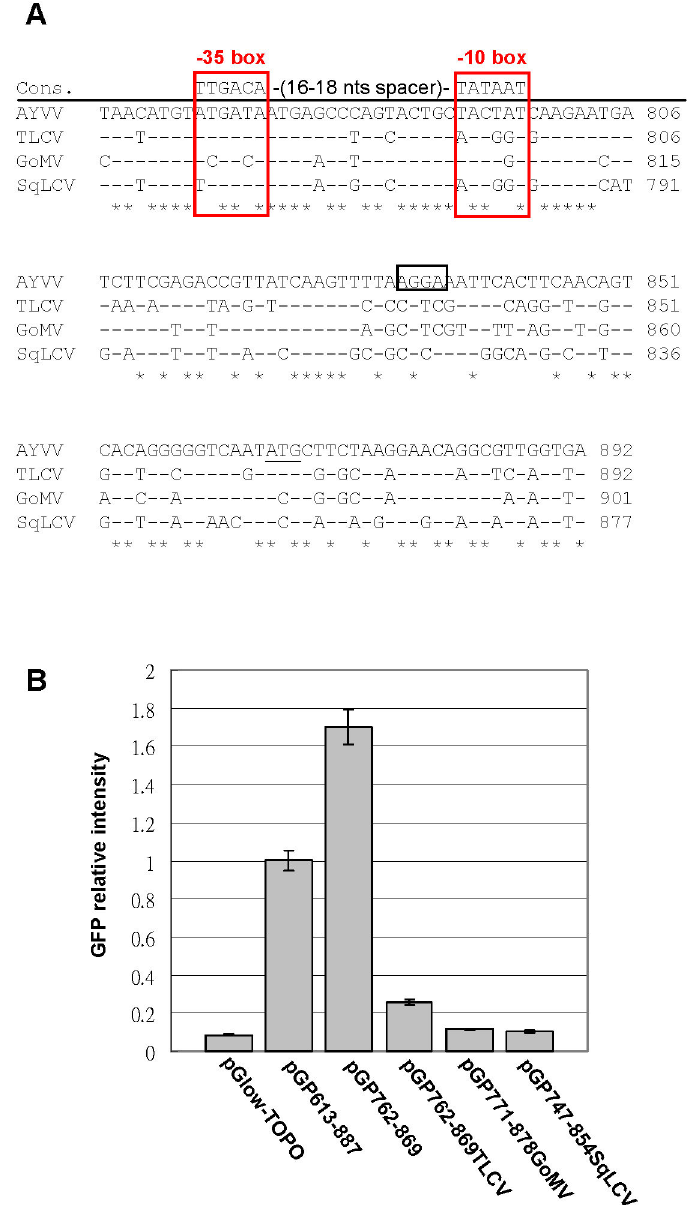
Figure 6. Analysis of promoter activities in the regions corresponding to the AYVV-NT AV3 promoter in various begomoviruses. (A) Comparison of nucleotide sequence similarities among the AV3 promoter corresponding regions in different begomoviruses. The respective nucleotide positions are indicated by numbers on the right. The consensus sequence of prokaryotic promoter containing the -35, -10 regions (in red boxes) are shown above the alignment for comparison. Nucleotide sequences identical to that of the AYVV-NT are represented by a dash. Conserved sequences among all sequences are indicated by an asterisk under the alignment. The putative endogenous RBS (-AGGA-), and the start codon (ATG) of the AYVV-NT sequence are in black box and underlined, respectively. (B) Relative promoter activities of the AV3 promoter corresponding regions from various begomoviruses were quantified as described in Figure